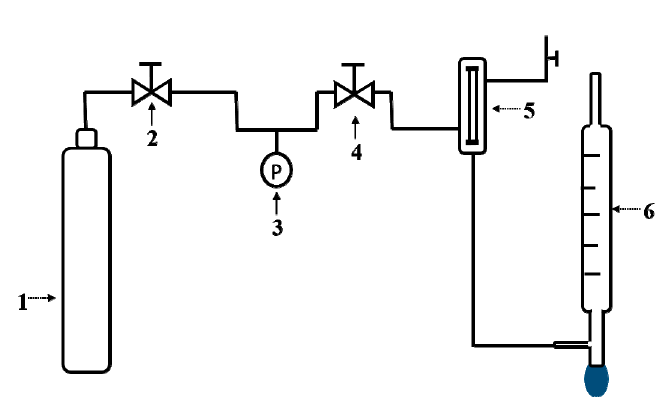
Figure 1. Single gas permeation measurements: (1) cylinder; (2) reducing valve; (3) pressure gauge; (4) counterbalance valve; (5) membrane module; (6) soap bubble flowmeter. (4) counterbalance valve; (5) membrane module; (6) soap bubble